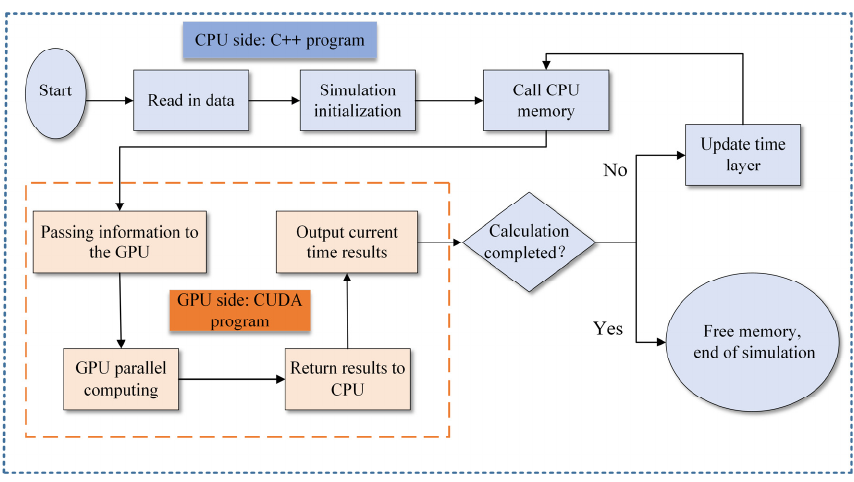
Figure 4. GPU acceleration flowchart.